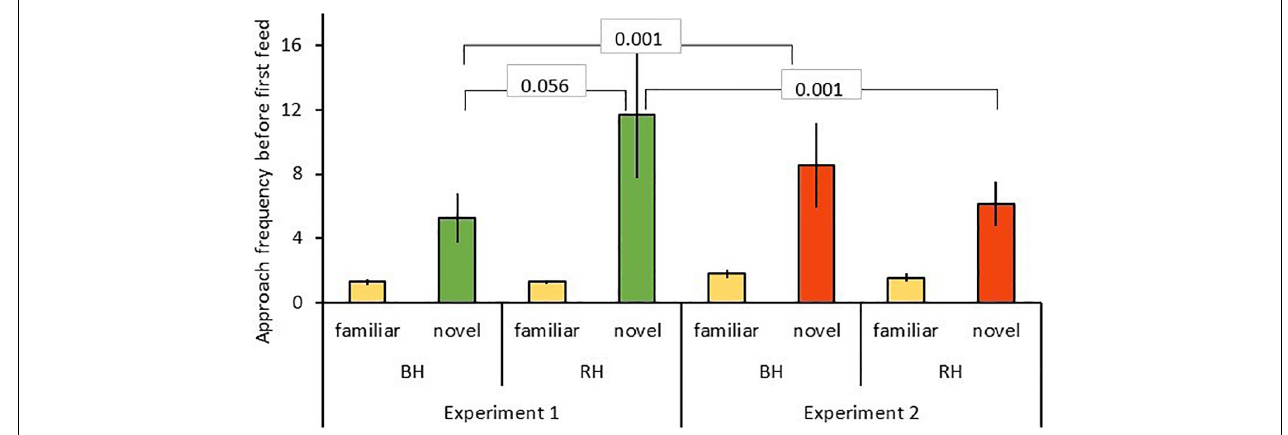
FIGURE 2 | Approach frequencies before first feed (mean ± SE) to familiar (beige) and novel food (green, red) in experiment 1 and 2 for red-headed (RH) and black-headed (BH) Gouldian finches. Numbers in the figure represent p -values.